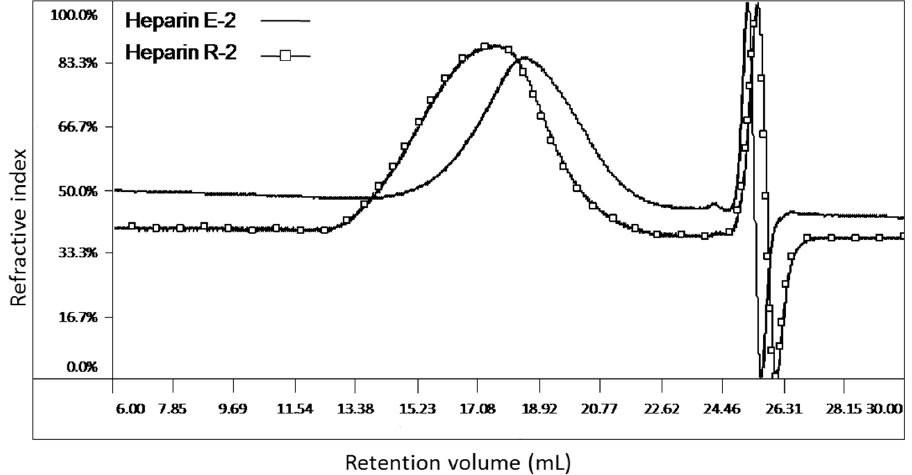
Figure 2. Phase 1: Molecular weight distributions for the samples of bovine mucosal heparin with highest (R-2) and lowest (E-2) molecular weights as measured by the USP Heparin Sodium monograph method. Chromatographic profiles refer to Method 1.